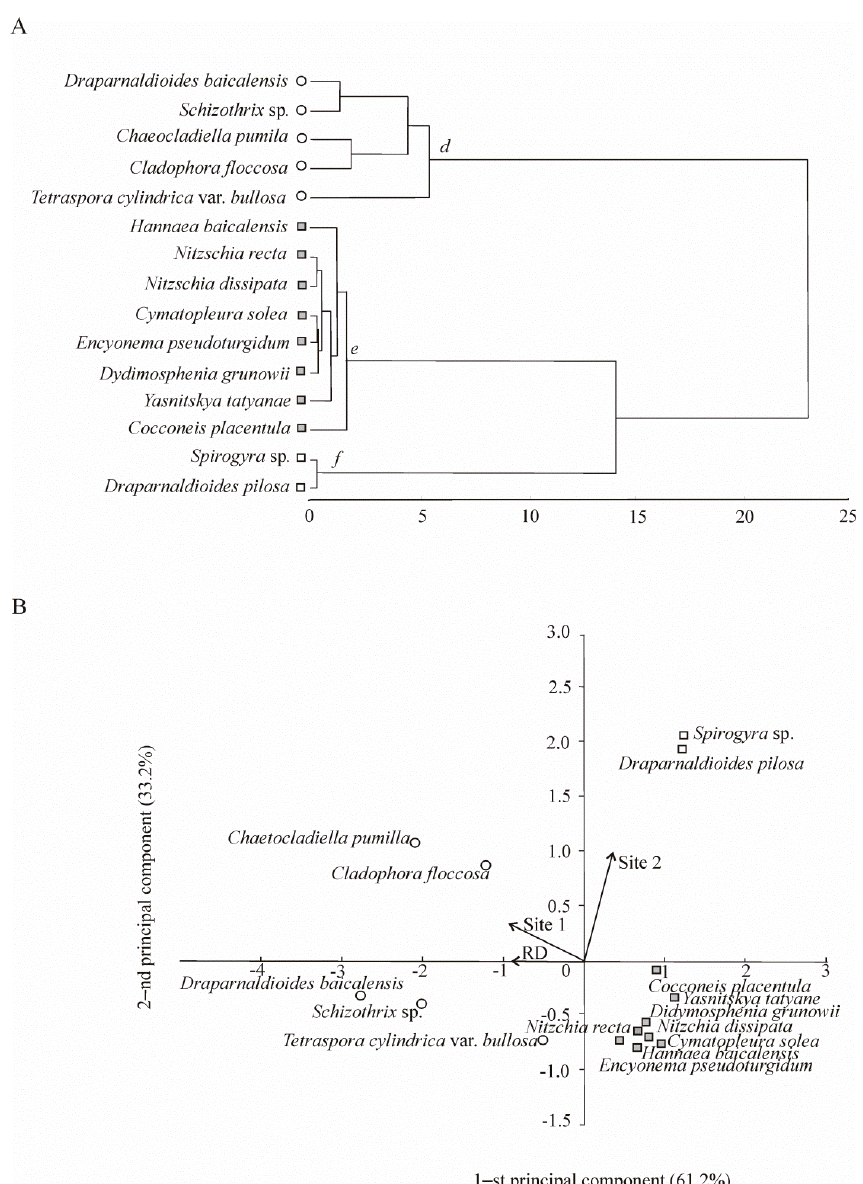
Figure 3. Benthic community structure and spatial distribution of dominant species in the coastal zone of Lake Baikal. ( A ) Species composition of benthic communities ( d , e , and f ) extracted by Ward’s cluster analysis using Euclidean distances. ( B ) Locations of the identified benthic communities in the plane of the first two principal components (PCA). RD—reference data, including samples collected on the stones from 0 to 5 m depth range in north-western direction 5 and 17 km off Listvennichny Cape in the past century; Site 1 included stations at transect 1 of the background area in 2016; Site 2 included stations at transect 2 of the area with human activity in 2016 (see Figure